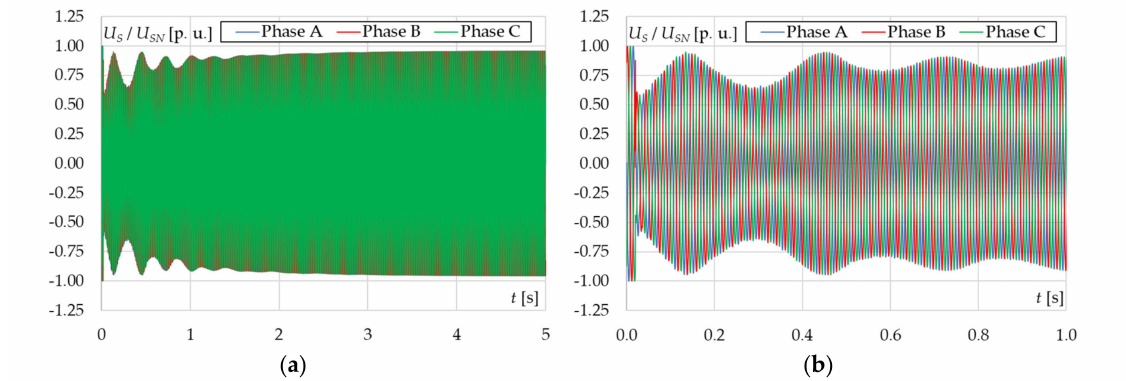
Figure 15. Waveforms of stator voltage during out-of-phase synchronization of − 120° in ( a ) the scope of the considered calculation time and ( b ) the first second.